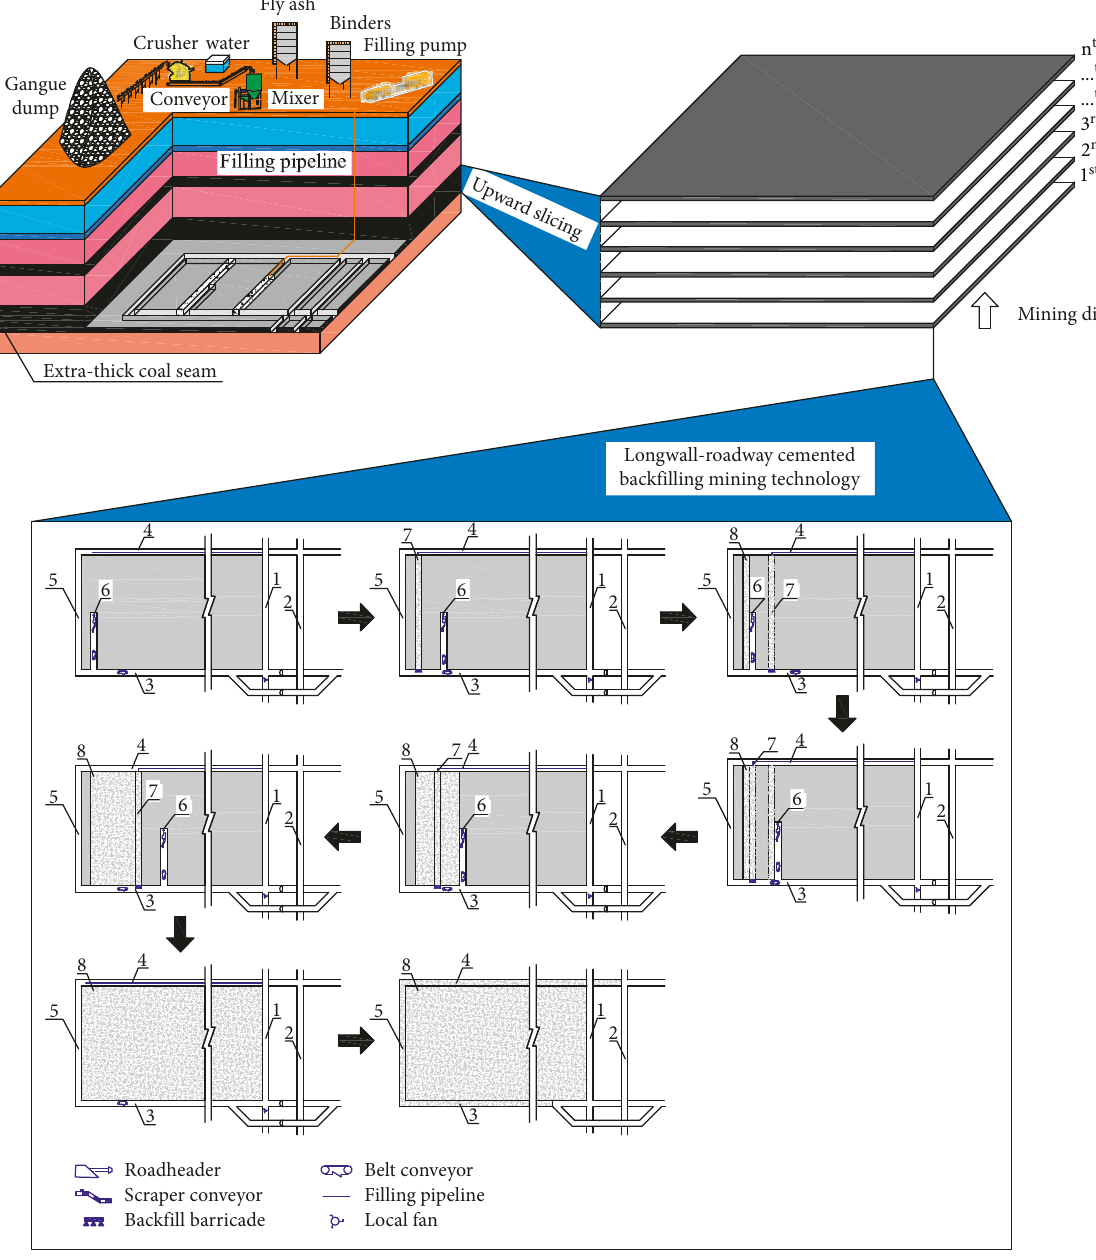
Figure 1: The technical principles of USLCB [14]. (1) Haulage rise; (2): rail rise; (3) headgate; (4) tailgate; (5) boundary crosscut; (6) mining working face; (7) backfilling working face; (8) backfilled